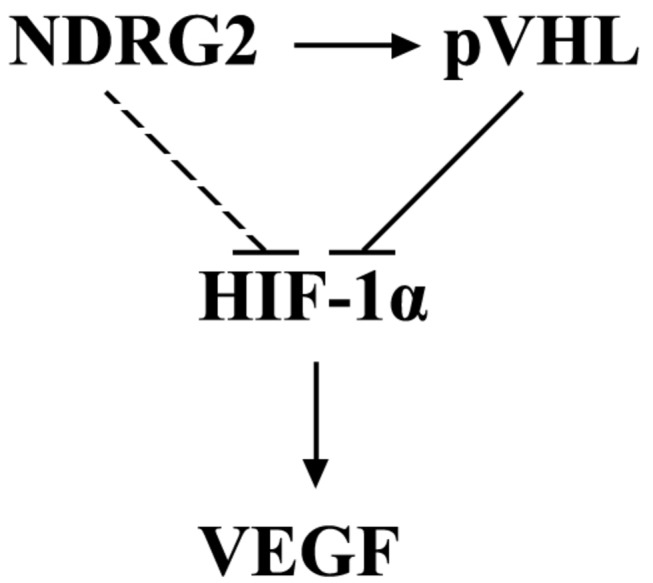
Proposed model that NDRG2 exerts its anti-tumor effect.The NDRG2 caused down-regulation of HIF-1α and VEGF was partly due to up-regulation of the tumor suppressor pVHL. It could not be excluded that NDRG2 may also regulate HIF-1α expression and consequent VEGF changes independent of pVHL.